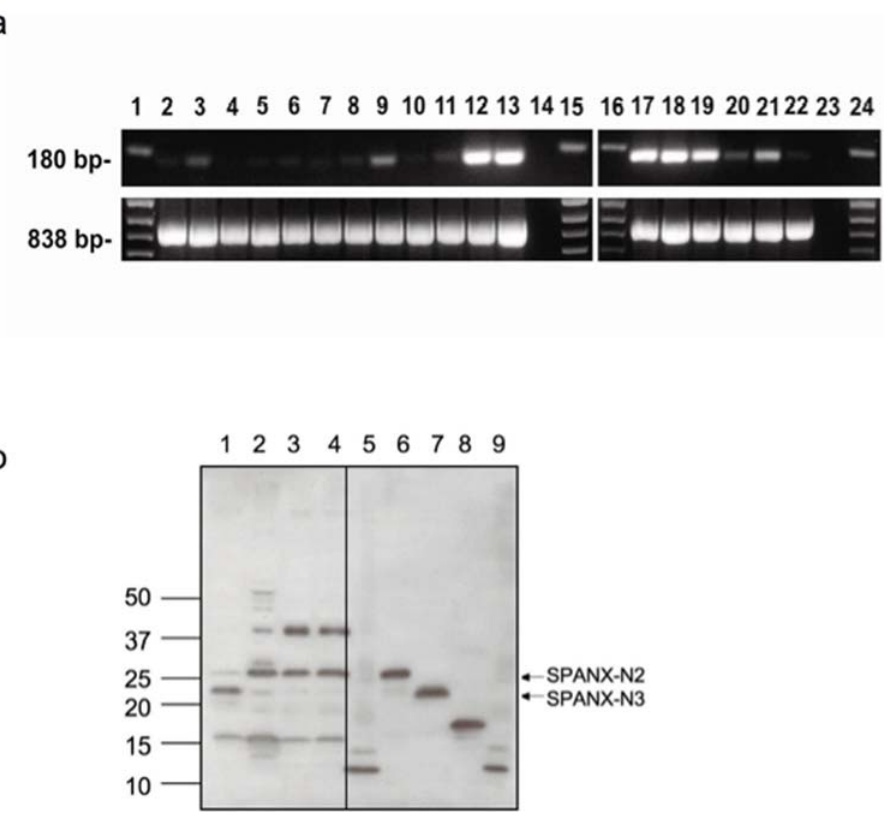
Figure 6. (a) RT-PCR analysis of the SPANX-N gene subfamily in normal adults tissues and cancer cell lines. cDNA was prepared from a panel of human tissue mRNAs and cell lines. Oligonucleotides were designed within exons 1 and 2 to amplify putative transcripts. The observed bands of the expected size 180 bp were sequenced and confirmed to correspond to SPANX-N genes. The strongest expression of SPANX-N genes was observed in the normal testis (lanes 12 and 17) and in the LOXIMV1 melanoma cell line (lanes 13 and 18). Lanes 2–11 correspond to normal and tumor pairs of breast, cervix, prostate, lung and ovary; lanes 19–21 correspond to 938MEL, 888MEL, SKMEL28 melanoma cell lines; lane 22 corresponds to the SKOV3 ovarian cell line; lanes 1, 15, 16, 24 – ladder; lanes 14 and 23 - water. The cDNA templates used were normalized using actin, as shown at the bottom of the panel. (b) Western blot analysis of lysates from normal tissues using an anti-EQPT antibody. Lane 1 - lung, lane 2 - testis, lane 3 - placenta and lane 4 – prostate. Lanes 5–9: full-size SPANX-N proteins expressed in the pET-11d in Bl21 cells. The mobility of SPANX-N proteins produced in E. coli cells is 13 kDa for SPANX-N1, 27 kDa for SPANX-N2, 23 kDa for SPANX-N3, 17 kDa for SPANX-N4 and 13 kDa for SPANX-N5.